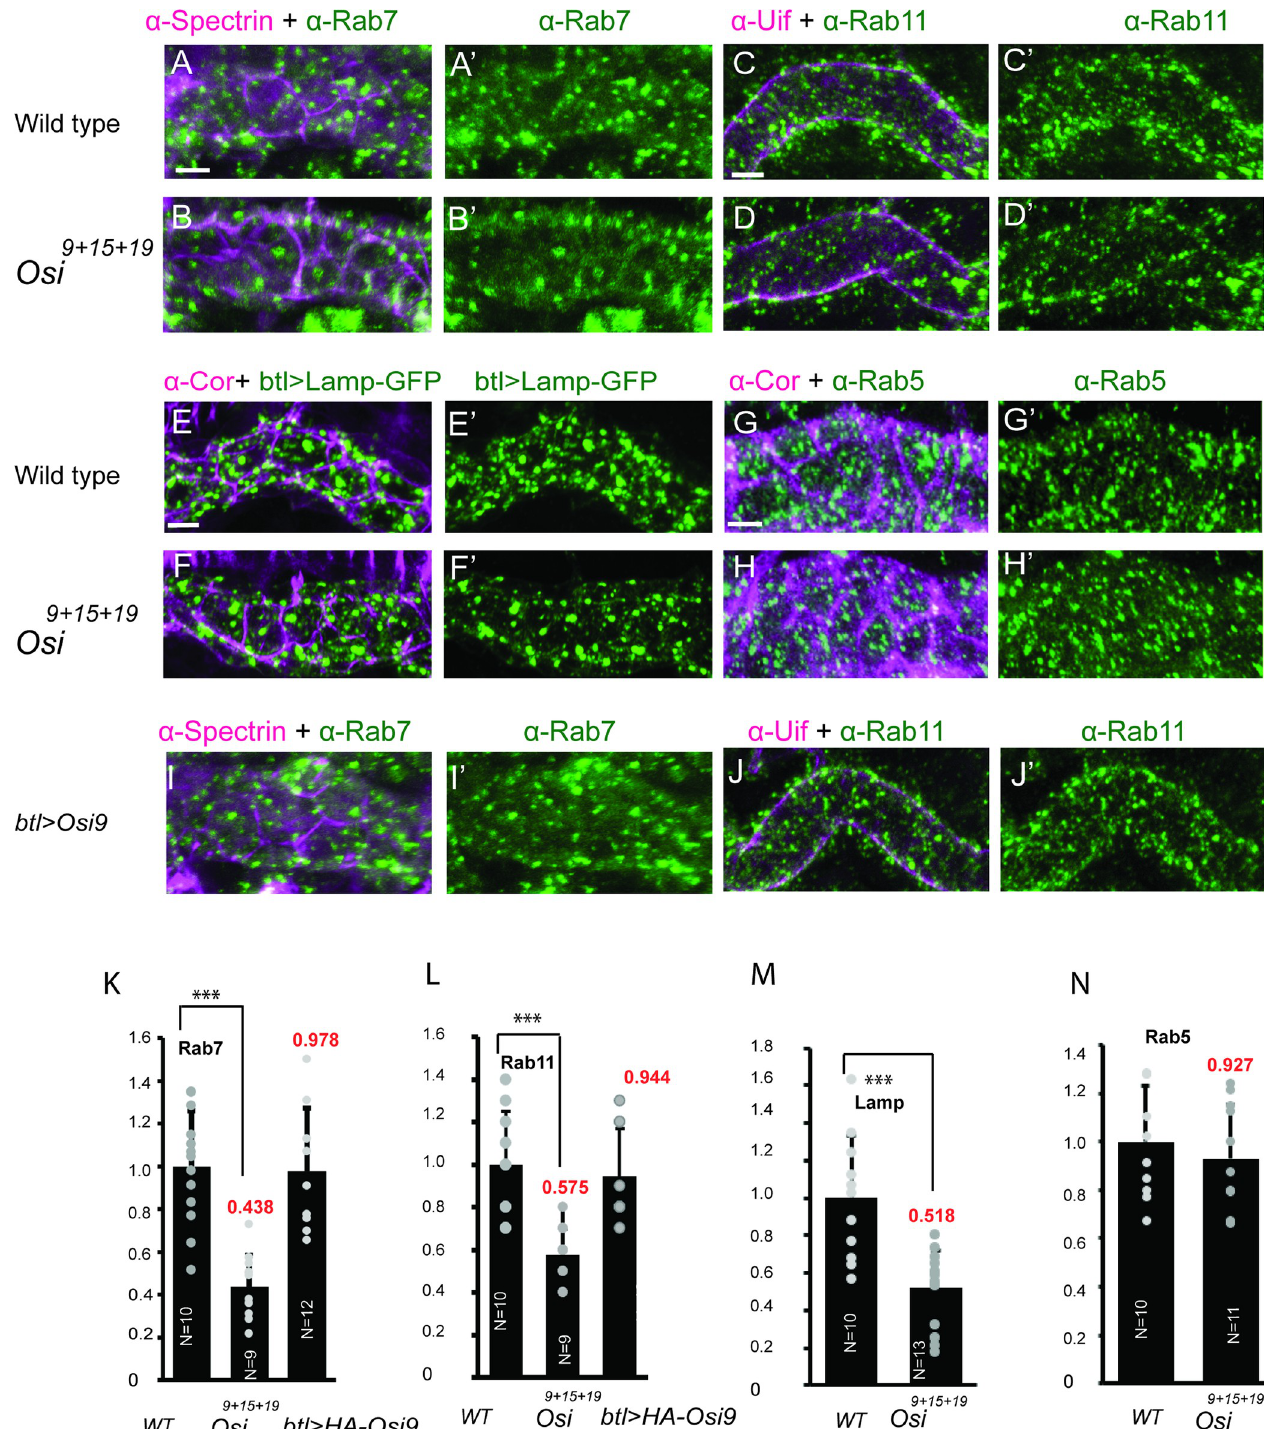
Fig 7. The numbers of late endosomes, lysosomes, and recycling endosomes are significantly reduced in Osi mutants. Numbers of endosomes (Rab5, Rab7, Rab11, btl > Lamp-GFP) were analyzed in late-stage 16 wild-type control and Osi 9+15+19 mutants. Tracheal cells were outlined by basolateral membrane markers α -Spectrin (purple) and α -Cor (purple) or apical membrane marker α -Uif (purple). Projection of DT tracheal segments 7 (14 sections, 0.5 um step size) was used as a region of interest (ROI). The number of Rab7 punctae (green) was reduced in Osi 9+15+19 mutant trachea (B-B’) compared to that in wild-type w 1118 trachea (A-A’). The number of recycling endosome Rab11 punctae (green) was reduced in Osi 9+15+19 mutants (D-D’) compared to that in wild-type control (C-C’). The number of lysosome btl > Lamp-GFP punctae (green) was reduced in Osi 9+15+19 mutant trachea (F-F’) compared to that in wild-type w 1118 trachea